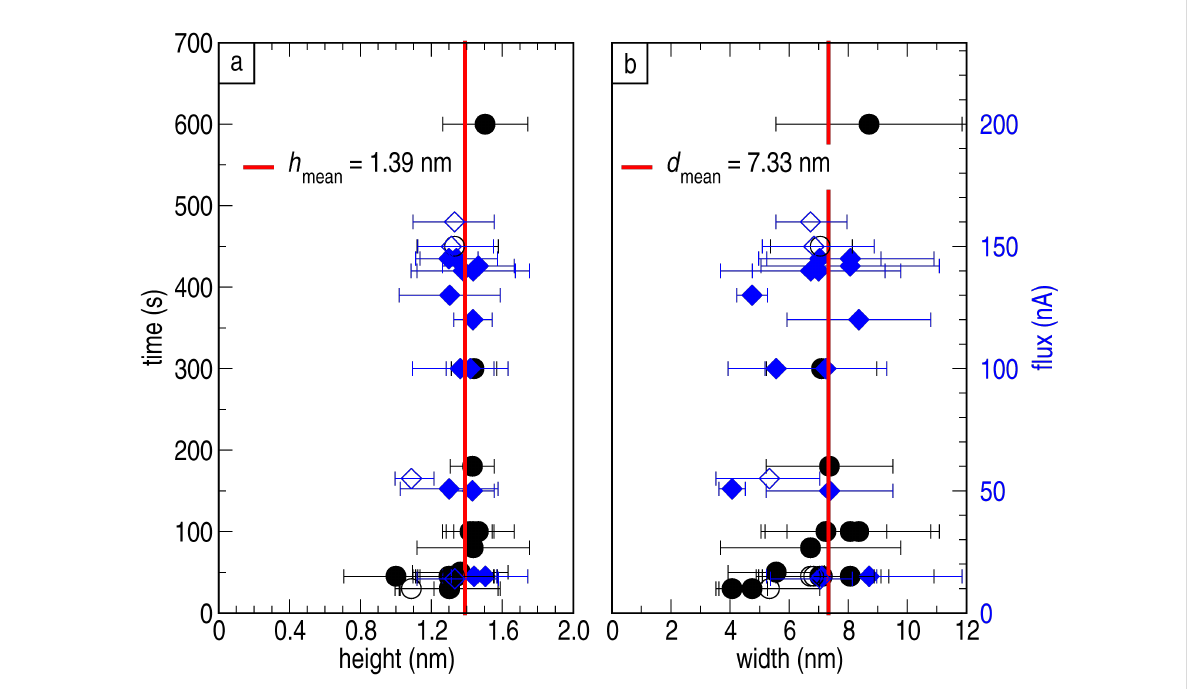
Figure 3: Analysis of the height (a) and width (b) dependence on deposition time (black circles) and flux (blue diamonds) during the evaporation process. The plots show no significant influence of the evaporation conditions on the size of the clusters.